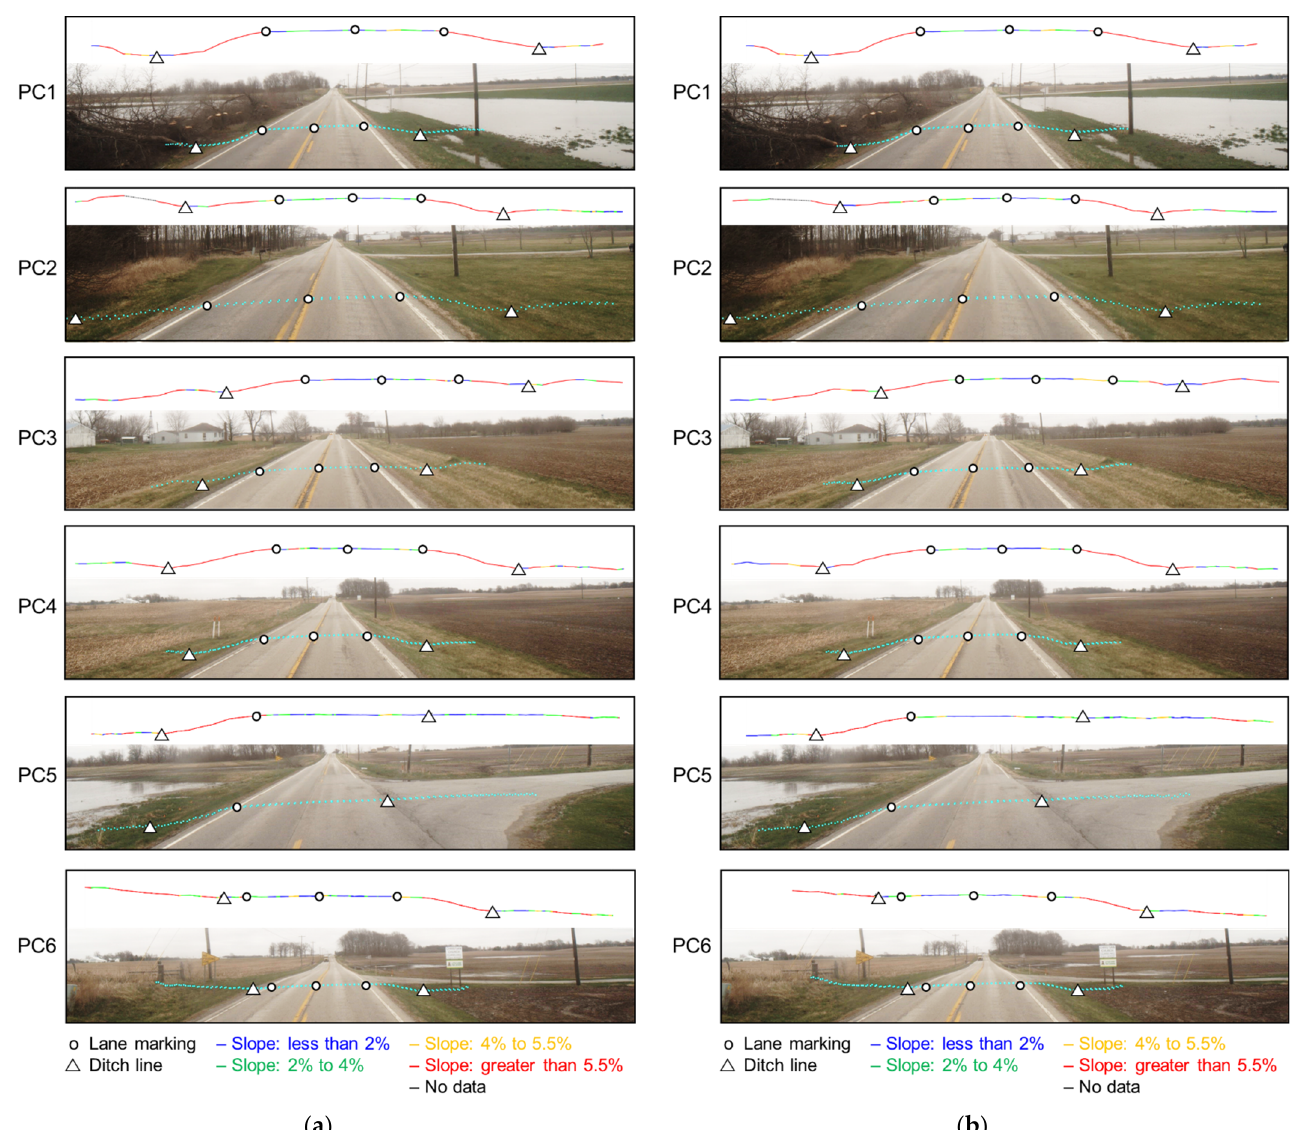
Figure 21. Cross-sectional profiles shown in 3D (side view and colored by slope) and the images from ( a ) PWMMS-HA and ( b ) Mobile-pack.